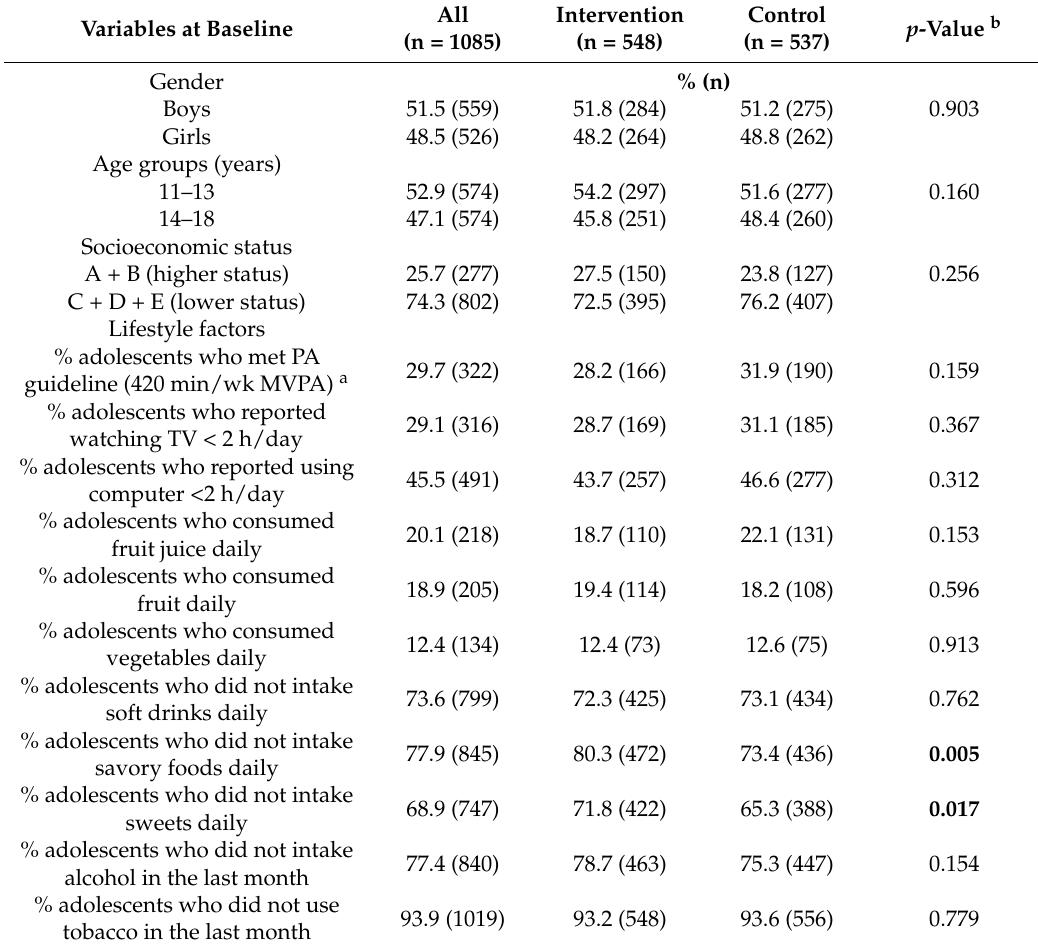
Table 2. Adolescents’ Characteristics at Baseline of the Fortaleça sua Sa ú de Program,